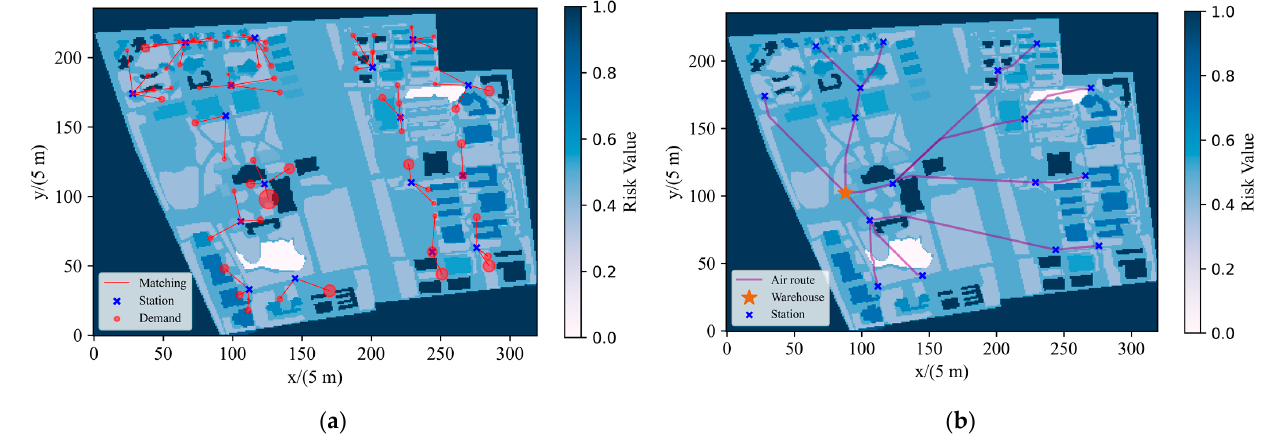
Figure 11. Logistics UAV parcel-receiving stations and public air-route planning result. ( a ) Parcel- receiving station location results and demand-point-matching relationship. ( b ) Public air-route planning results based on MMAS. Table 7. Location results of parcel-receiving stations. Table 8. Public air-route planning